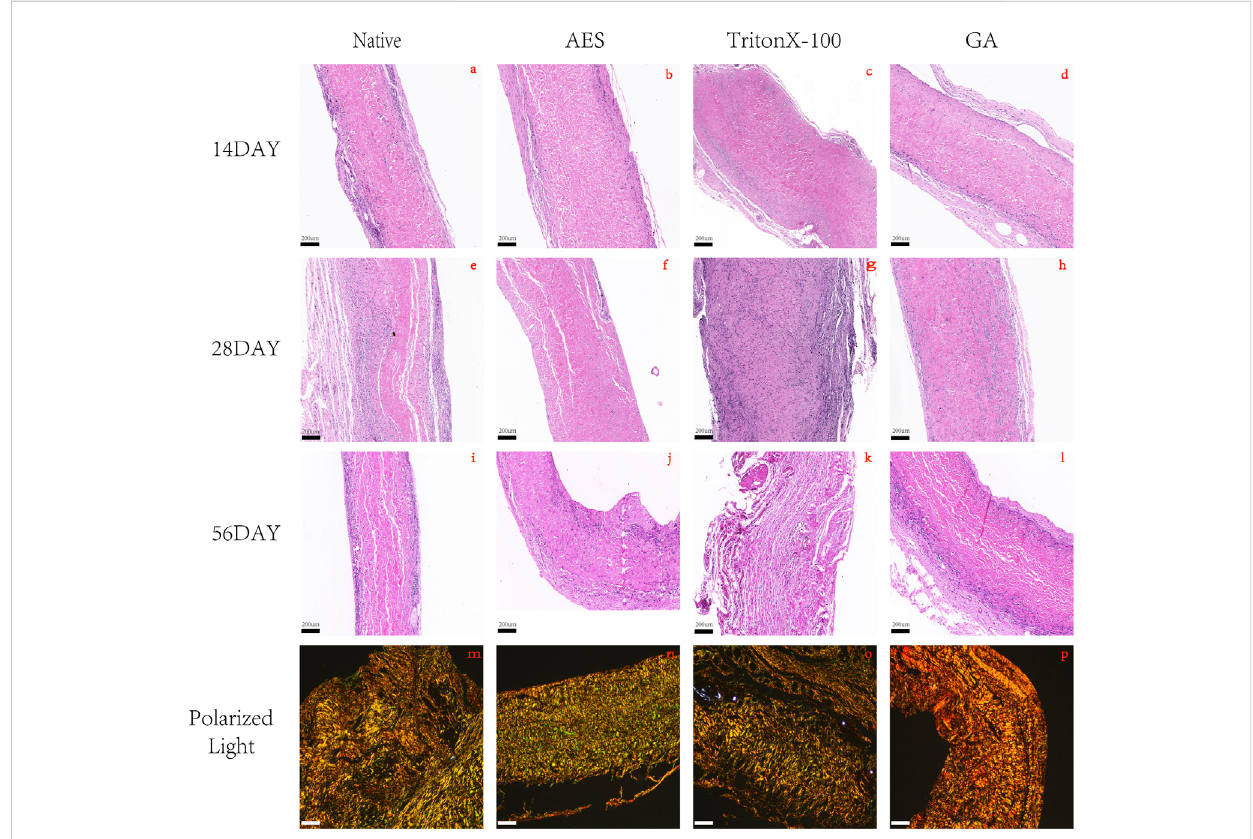
FIGURE 6 H&E staining after 14 days, 28 days, 56 days of subcutaneous implantation in rats. (A , E , I) Native; (B , F , J) AES; (C , G , K) TritonX-100; (D , H , L) GA, magni fi cation (×4). (M , N , O , P) 56days of Picro-sirus red staining: (M) Native; (N) AES; (O) TritonX-100; (P) GA, magni fi cation (×10); The color of type Ⅰ collagen fi bers is yellow/orange birefringence and type Ⅲ collagen fi bers is green birefringence. (Scale bars are 200